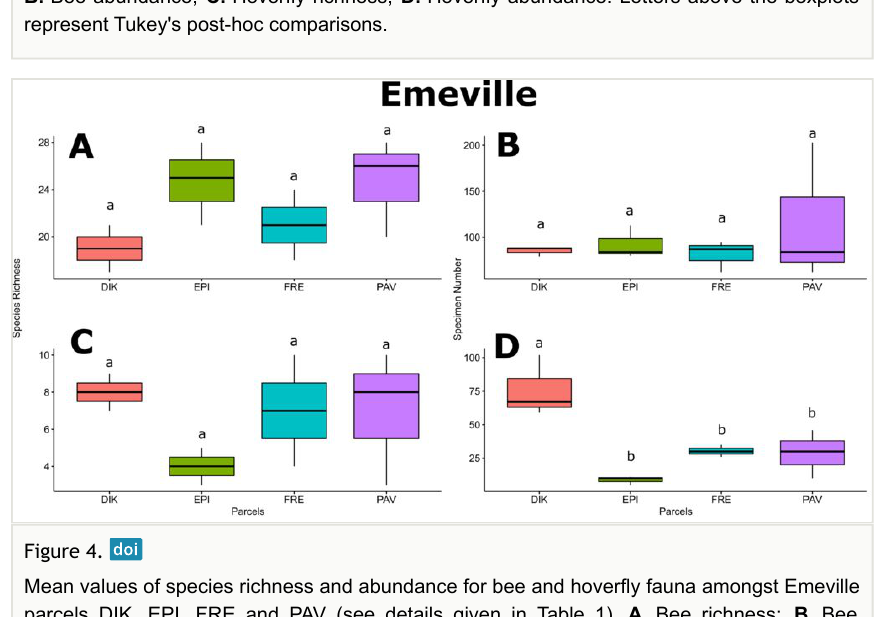
Figure 4. Mean values of species richness and abundance for bee and hoverfly fauna amongst Emeville parcels DIK, EPI, FRE and PAV (see details given in Table 1). A. Bee richness; B. Bee abundance; C. Hoverfly richness; D. Hoverfly abundance. Letters above the boxplots represent Tukey's post-hoc